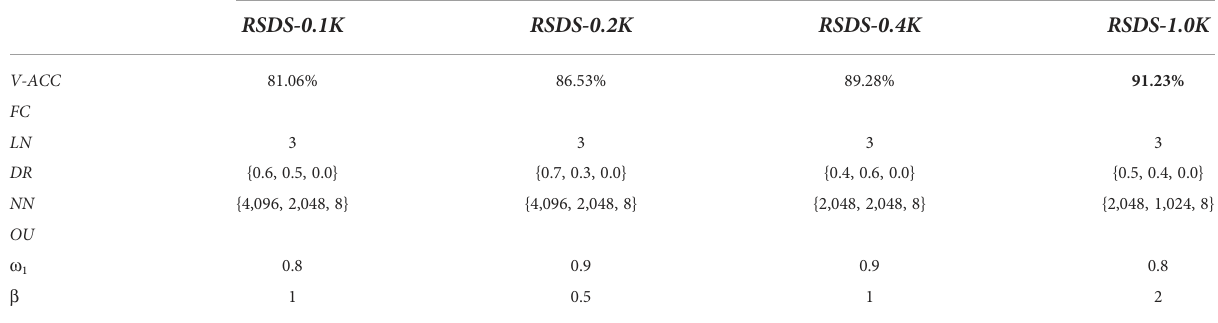
TABLE 4 TD-NAS on VGGNet-D (VGGNet-16) ( w 1 not fi xed